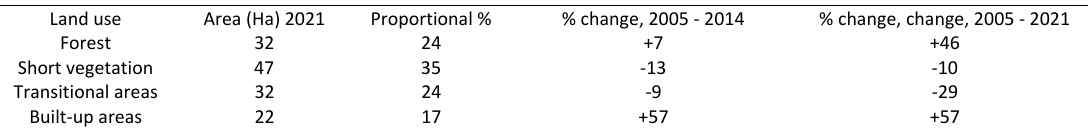
Table 5: Land use in 2021 and comparative land use change